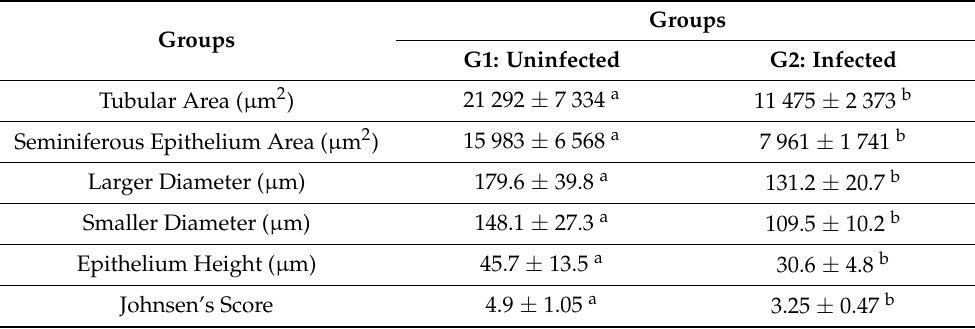
Table 3. Seminiferous tubule ( n = 10 per testicle) measurements and Johnsen’s score of squirrel monkeys ( Saimiri collinsi ) on the 21st day following infection with Zika virus. Groups